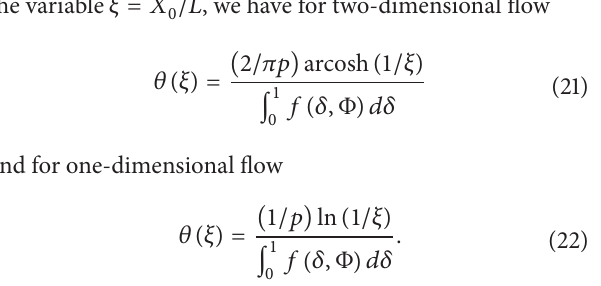
Figure 1: Parameter 𝜃 distribution along the